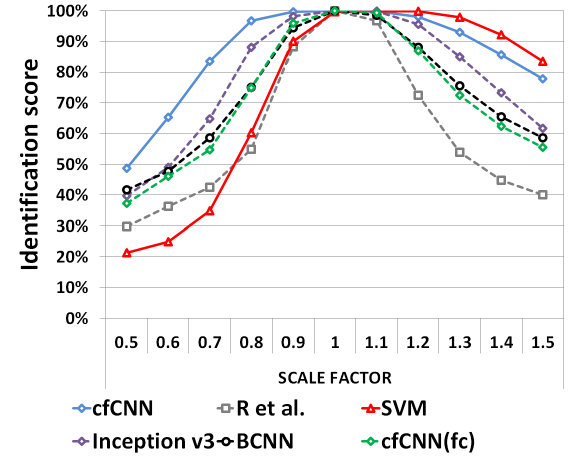
Figure 12. The identification scores obtained on the TSS